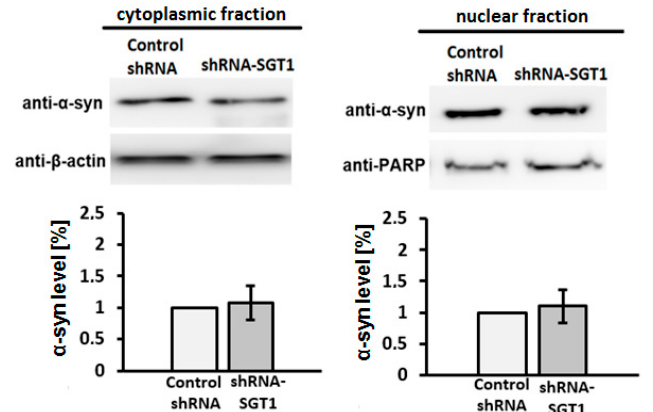
Figure 4. Effect of diminished SGT1 level on α -synuclein subcellular localization in HEK293 cells. ( Upper panels ) Representative Western blots showing the level of α -synuclein in cytoplasmic and nuclear fractions obtained from cells with diminished SGT1 level (shRNA-SGT1) or control ones (control shRNA). ( Lower panels ) Statistical analysis of densitometry results obtained from